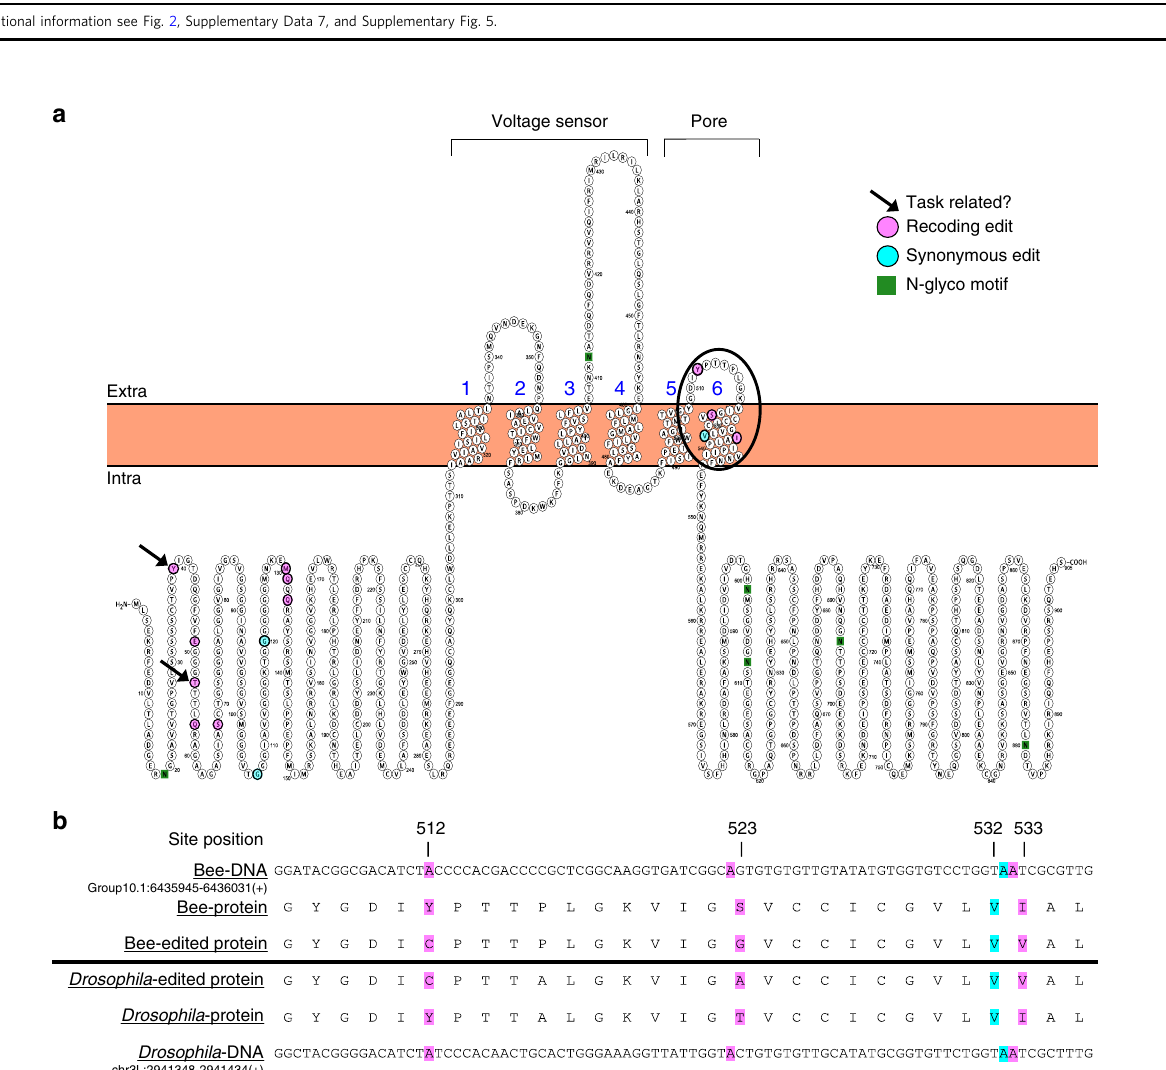
Fig. 2 A-to-I RNA editing of the bumblebee Shab voltage-gated ion channel transcript. a A predicted model of the Bombus terrestris Shab -like protein showing the location of edited sites. The arrows point to sites differentially edited between nurses and foragers. Recoding (non-synonymous) and synonymous sites are highlighted in pink and light-blue, respectively. The cluster of four highly conserved editing sites on the 6th transmembrane domain is highlighted with a black circle. These four sites are conserved in other insects, cephalopods (the three recoding sites) and mammals (the last recoding site). b Alignment of the Shab gene for Bombus terrestris (top) and Drosophila melanogaster . Predicted conserved RNA editing sites are highlighted (pink – recoding; light-blue-synonymous) (see also Table 2 and Supplementary Fig. 5) level in any of the three sites ( P -values = 0.47, 0.36, and 0.31, respectively, data not shown).